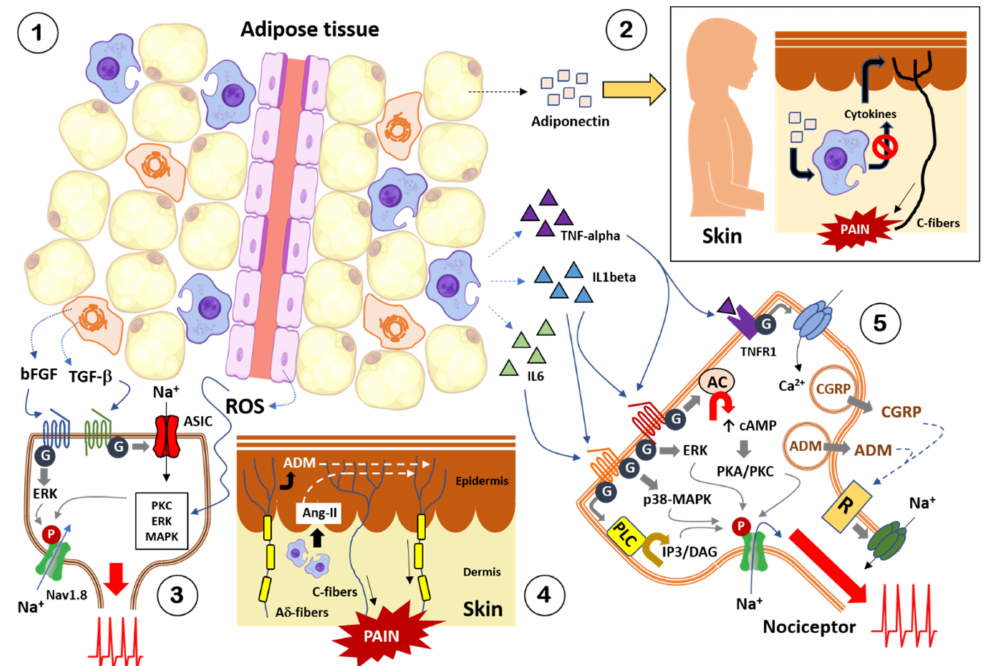
Figure 2. Crosstalk between adipose tissue, skin, and visceral nociceptors. There is a multitude of diffusible factors secreted by adipose tissue that interact with nociceptors, triggering pain. (1) Adipose tissue is made up of an accumulation of adipocytes, macrophages, lymphocytes, neutrophils, T-cells, natural killer cells, and fibroblasts, as well as an extensive network of blood vessels. (2) Adipocytes secrete adipokines, such as adiponectin, which can reach the skin through the bloodstream. Under an inflammatory condition of the skin, the cutaneous macrophages secrete cytokines, which excite and sensitize the cutaneous nociceptors, triggering pain. Adiponectin acts on these macrophages, inhibiting the release of pain-inducing cytokines. Therefore, this adipokine has analgesic effects. (3) Fibroblasts from adipose tissue accumulated in body tissues and organs secrete growth factors that interact with G protein-coupled receptors on the membrane of nociceptors. Some of these growth factors activate intracellular cascades (e.g., ERK) that allow peripheral sensitization through ion channel phosphorylation (e.g., Nav1.8), thus favoring cation fluxes that trigger depolarization of nociceptors and pain. Other growth factors modulate ion channel opening (e.g., ASIC) and cation entry and depolarization of the nociceptor. Together, growth factors secreted by fibroblasts in adipose tissue cause hyperexcitability of nociceptors and pain. On the other hand, the endothelial cells of the blood vessels that supply adipose tissue secrete oxygen free radicals (ROS) that diffuse to the nociceptors, modulating various intracellular signaling pathways, which cause ion channel phosphorylation, peripheral sensitization and hyperarousal of nociceptors. (4) Inflammation of body tissues, such as the skin, triggers the nociceptors themselves to release adrenomedullin (ADM) or macrophages to release angiotensin-II (Ang-II), two adipokines also secreted by adipose tissue. Both diffusible factors act on receptors in the membrane of cutaneous (or visceral) nociceptors, modulating the opening of ion channels, cation fluxes, and depolarization, causing pain. (5) The macrophages (and other immune cells) of the adipose tissue accumulated in the organs of obese subjects, secrete various cytokines, which by diffusing can interact with specific receptors present in the membrane of visceral nociceptors. The interaction of cytokines is carried out on receptors coupled to G proteins. Some of these interactions (e.g., TNF-alpha) modulate the opening/closing of ion channels, causing variations in the influx of calcium ions. These ions favor the fusion of vesicles loaded with peptides (e.g., pep-tide related to the calcitonin gene or CGRP, adrenomedullin or ADM) present at the terminals of nociceptors. Thus, adipose tissue cytokines cause the release of CGRP and ADM by visceral nociceptors, peptides that interact with their respective receptors (R) that end up regulating the opening of ion channels that favor the entry of sodium ions and depolarization of the nociceptor. At other times, cytokines released by adipose tissue regulate various intracellular cascades (e.g., cAMP/PKA-PKC, ERK, p38-MAPK, IP3/DAG) responsible for the phosphorylation of ion channels and other metabotropic receptors on the nociceptor membrane, triggering peripheral sensitization and hyperexcitability of the nociceptive afferent nerve fiber. In summary, in obese subjects, there is a powerful crosstalk between the accumulated adipose tissue in the body organs and the nociceptive afferent nerve fibers present in these organs, so that the diffusible factors secreted by the adipose tissue cause sensitization and hyperexcitability of the nociceptor, triggering pain. For details, see the main text. Source for figure illustrations: https://scidraw.io/ (accessed on 8 September